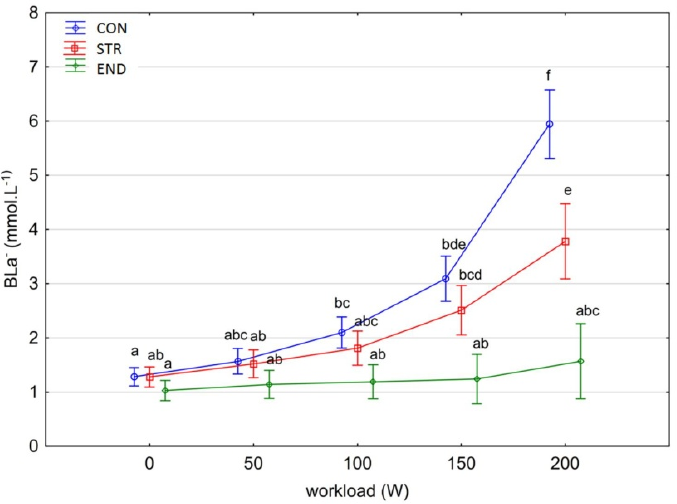
Figure 7. Blood lactate (BLa – ) at rest and its response during the progressive exercise test; point and whiskers—mean ± 95% CI; the signs—a, b, c, d, e, f indicate homogeneous groups ( post-hoc Tukey’s HSD test: p > 0.05).